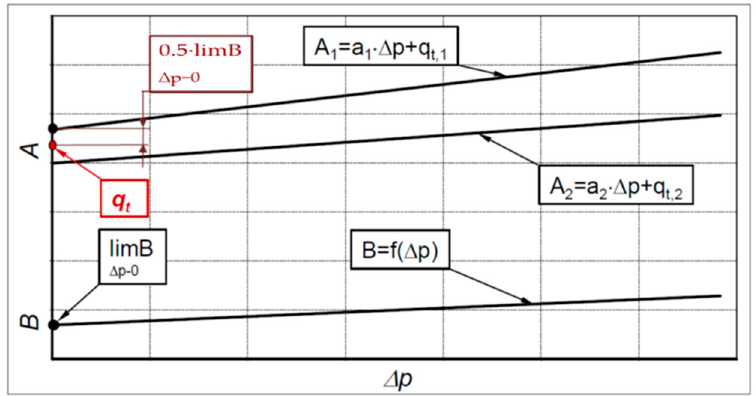
Figure 4. Working volume A and leakage B vs. pressure difference Δ p for hydraulic motor [7,8].